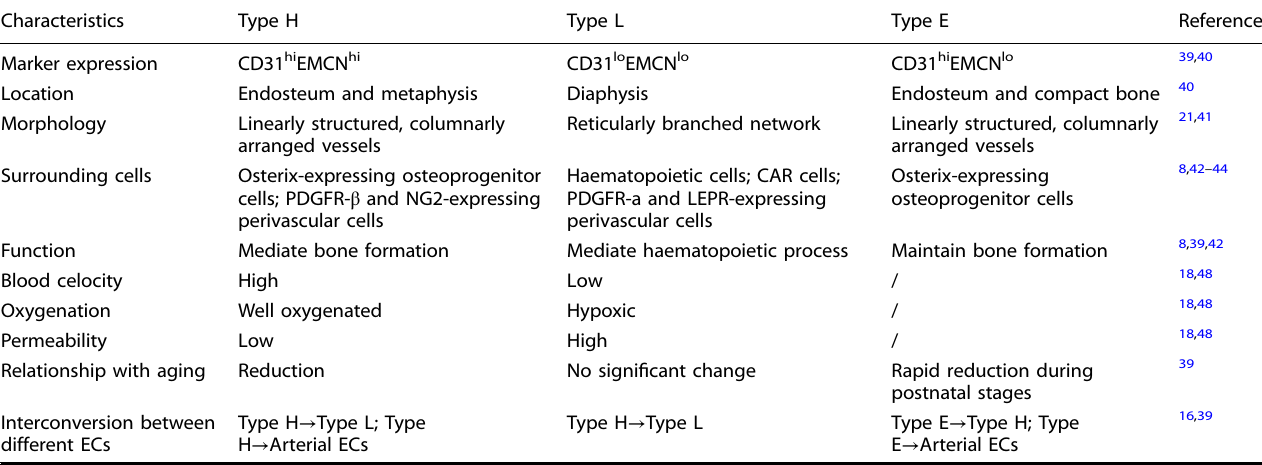
Table 1. Characteristic data of type H, L and E endothelial cells